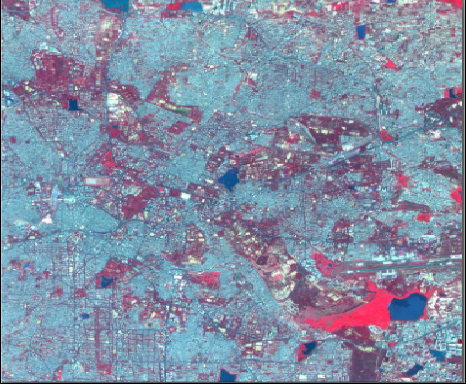
Figure 2: Cartosat 2S and LISS IV Merged Data